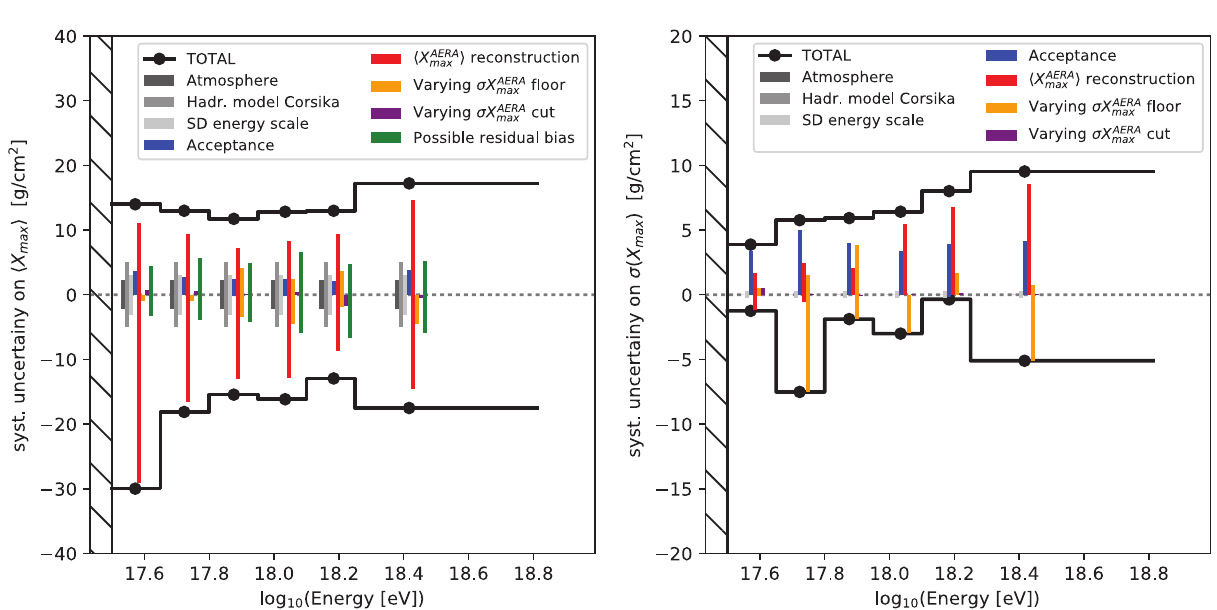
Figure 4. Contributions (bars) to the total systematic uncertainty (black lines) on (cid:4) X max (cid:5) (left) and σ ( X max ) (right) for six energy bins centred on the mean energy of each bin (black